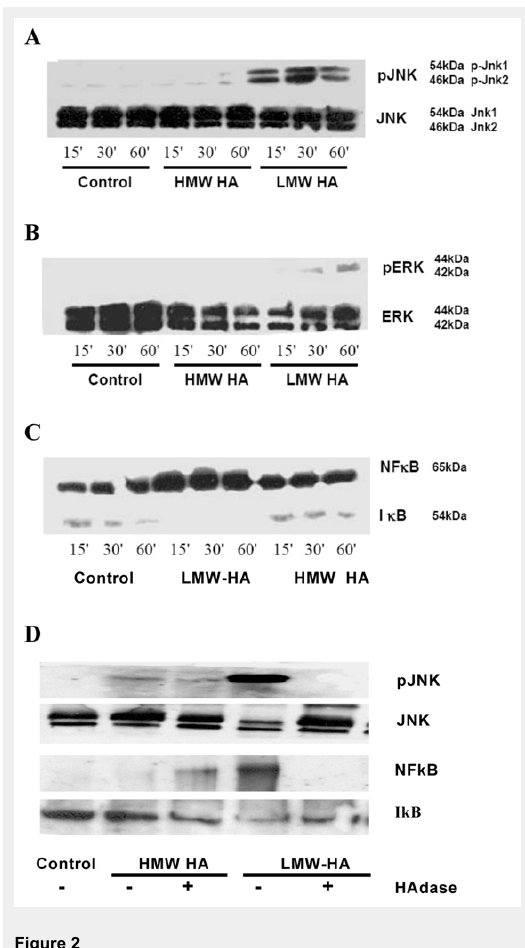
Figure 2 LMW-HA from bovine vitreous humor, but not HMW HA or HAdase treated LMW-HA from rooster comb, activated the JNK, ERK and NF-κB/IκB pathways in human BEAS-2B bronchial epithelial cells. Western blot analysis of effects of LMW-HA on BEAS-2B human transformed bronchial epithelial cells: A. c-Jun NH 2 -terminal kinase, B. ERK1 and ERK-2, and C. NF-κB in nuclear fraction / IκB in cytosol fraction, D. c-jun N-terminal kinase, NF-κB and IκB expression with HAdase treated HMW and LMW-HA. Each blot is representative of 3 separate experiments, and was quantified using densitometry. Results are expressed as fold- change compared with control in arbitrary units. * p <0.05 vs control. ‡ p <0.05 vs